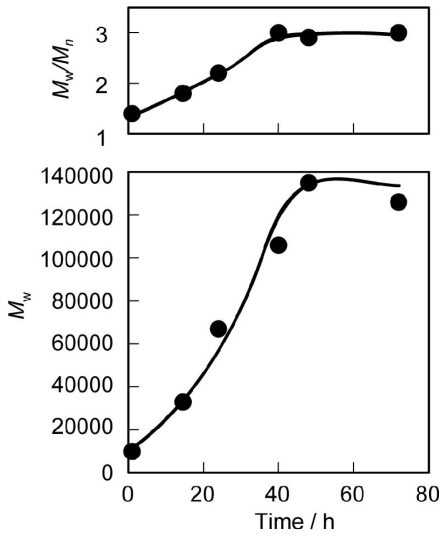
Time course of Mw and Mw/Mn of PEEU(6) at 100 °C. Reaction conditions: 2 (11.4 mg, 0.02 mmol), hexaethylene glycol (5.6 mg, 0.02 mmol), 1,2-dimethoxybenzene (0.057 mL), CALB (6.8 mg).